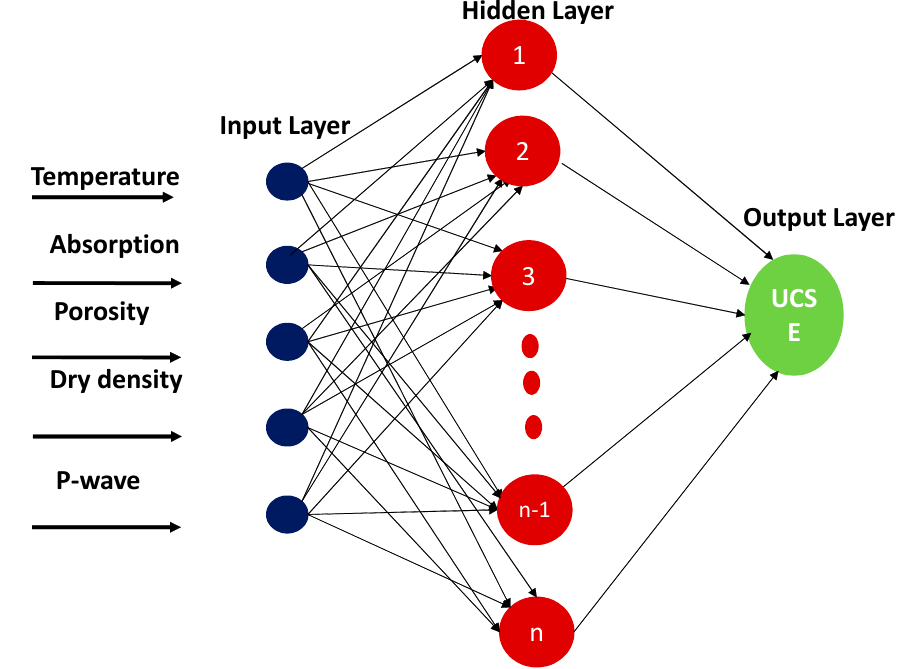
Figure 4. The structure of ANN for UCS and E predictions.